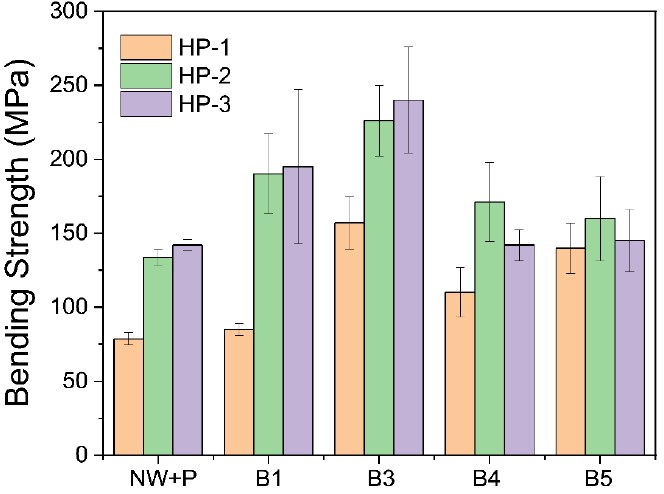
Figure 7. Bending strength of CW specimens prepared by various bleaching and hot-pressing con-